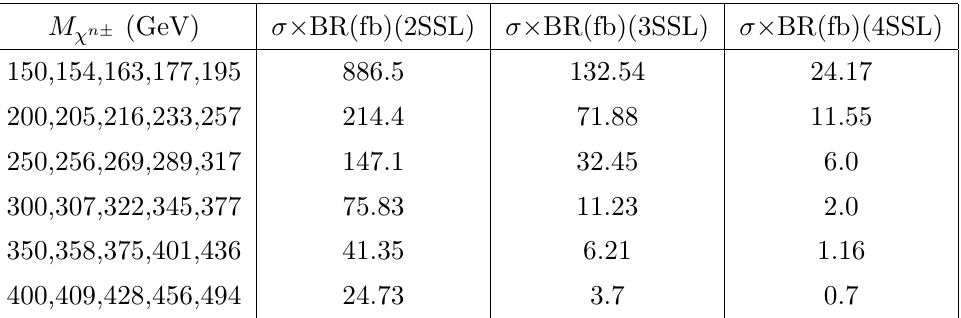
Table 2 . Signal cross-sections (production cross-section e(cid:11)ective BR) in the 2SSL, 3SSL, and (cid:2) 4SSL channels at the 13 TeV LHC for di(cid:11)erent masses of the quintuplet. Here n runs from 0 to 4 for a given quintuplet. This cross-sections are obtained considering both quarks and photons in the initial state. We consider BR( (cid:31) Q +1 l(cid:23)(cid:31) Q ) = 0.22 ( l = e; (cid:22) ), and BR( (cid:31) Q +1 qq(cid:31) Q ) = ! !